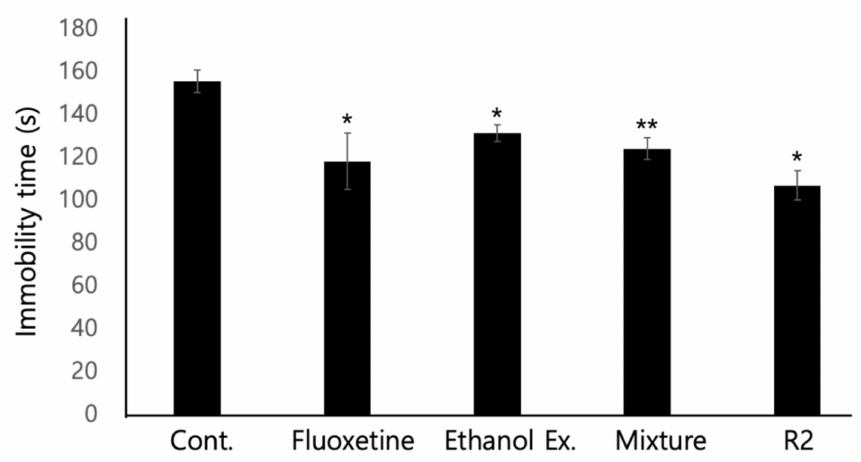
Figure 6. Purified fractions of P. eryngii increased immobility time in the FST experiment. To confirm the antidepressant activity of the extract of P. eryngii , a forced swimming test (FST) was performed, as described in the Materials and Methods. Each drug was administered by i.p. with 20 mg/kg concentration. Four mice were used in each group, and two independent experiments were performed. * p < 0.05, ** p < 0.01 indicate a significant difference compared to the control